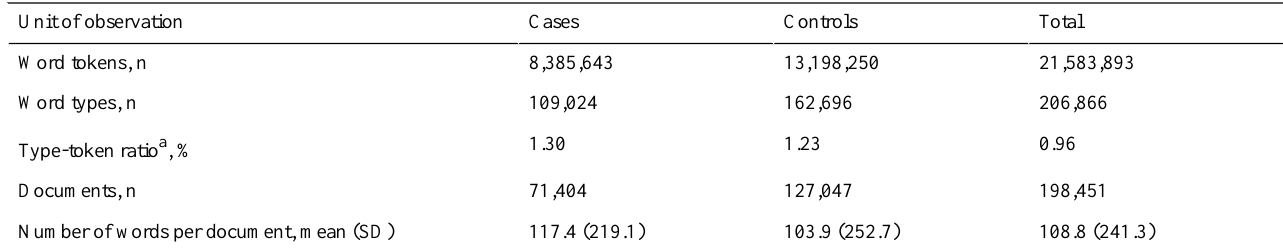
Table 2. Electronic health record corpus descriptive statistics. TotalControlsCasesUnit of